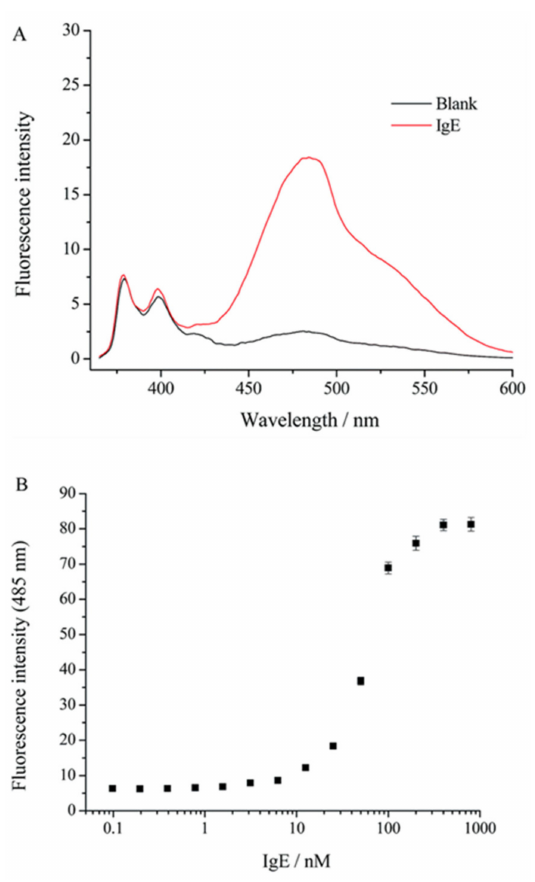
Figure 9. ( A ) The fluorescence spectra of the probe IgE-4bp-2Py (50 nM) in the absence and the presence of IgE (50 nM). ( B ) The fluorescence intensity (485 nm) at different concentrations of IgE [36]. Pak and co-workers [37] developed a chemical reaction-based ratiometric fluorescent probe 4 (Figure 10) for detection of hypochlorite (OCl − ). Probe 4 was constructed by the conjugation of a pyrene unit as fluorophore and an imidazoline-2-thione as a reactive site. The probe aggregated to excimer in PBS (pH = 7.4) with fluorescence at 480 nm, and upon reaction with OCl − , the reactive site imidazoline-2-thione was oxidized to imidazoline, which exhibited monomer fluorescence at 378